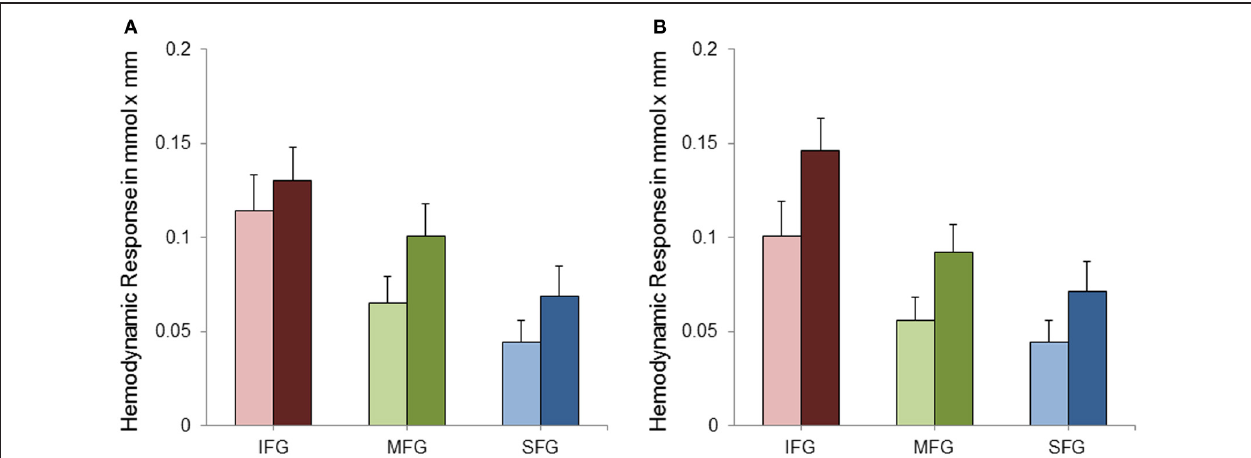
FIGURE 4 | Mean hemodynamic response and standard error of mean (SEM) for the left (A) and right (B) inferior frontal gyri (IFG), middle frontal gyri (MFG) and superior and medial frontal gyri (SFG) separately for the simple (SA; bright bars) and complex (CA; dark bars) mental arithmetic condition.